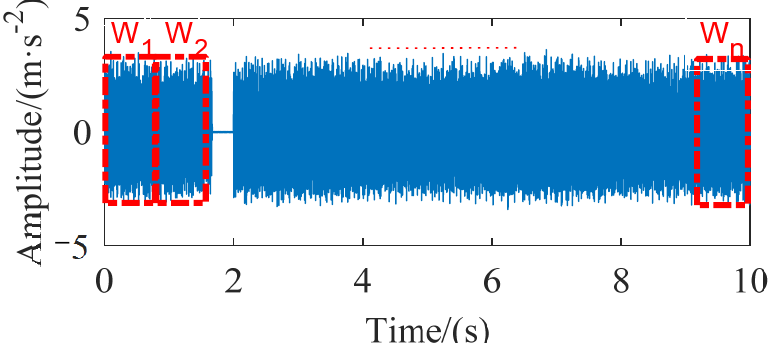
Figure 3. The data segmentation using a sliding rectangle window.